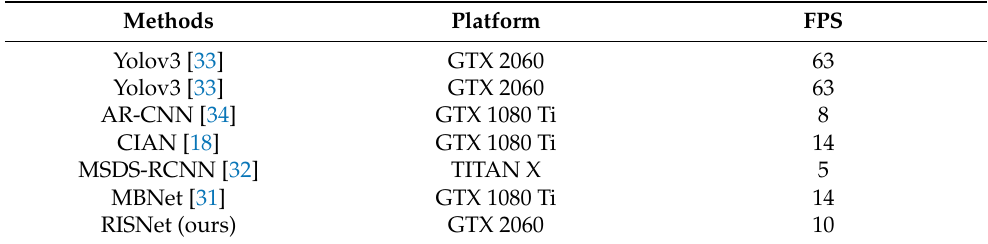
Table 3. FPS of different algorithms tested on different platforms. Ranking of computing performance (TFLOPs) of three computing platforms: GTX 1080 Ti (11.3 TFLOPs) > ITAN X (11 TFLOPs) > GTX 2060 (6.45 TFLOPs).